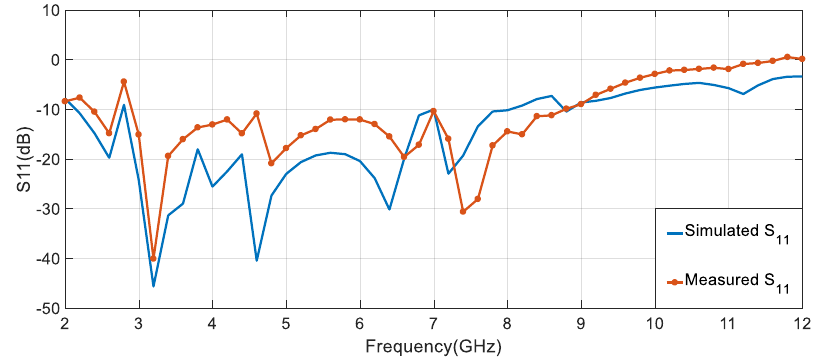
Figure 27. S 11 for the fabricated antenna with C-SRR.